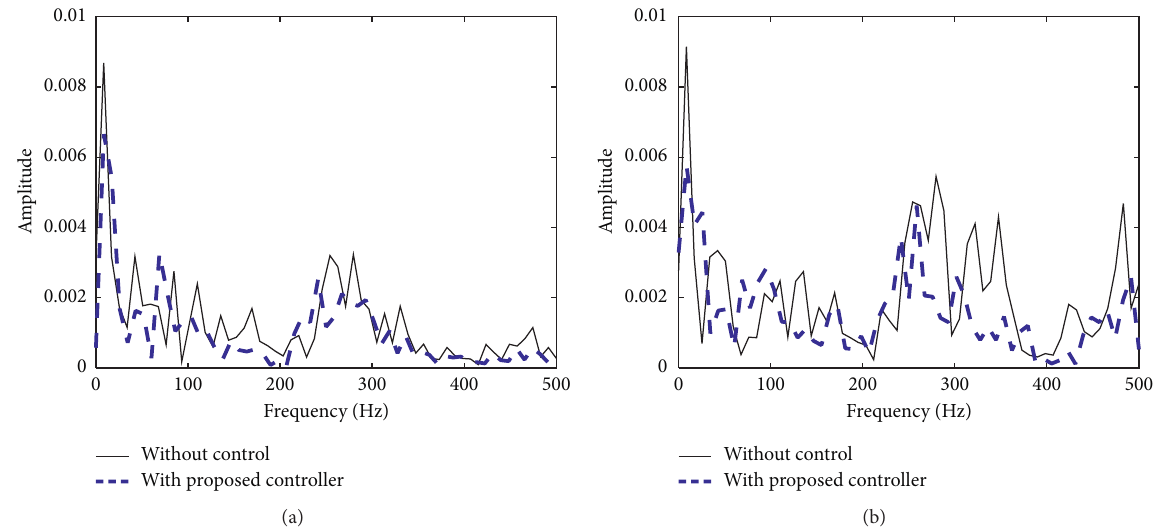
Figure 15: Experimental results of the elevation part in launching process for the 3rd rocket in frequency domain: (a) the yawing angular velocity and (b) the pitching angular